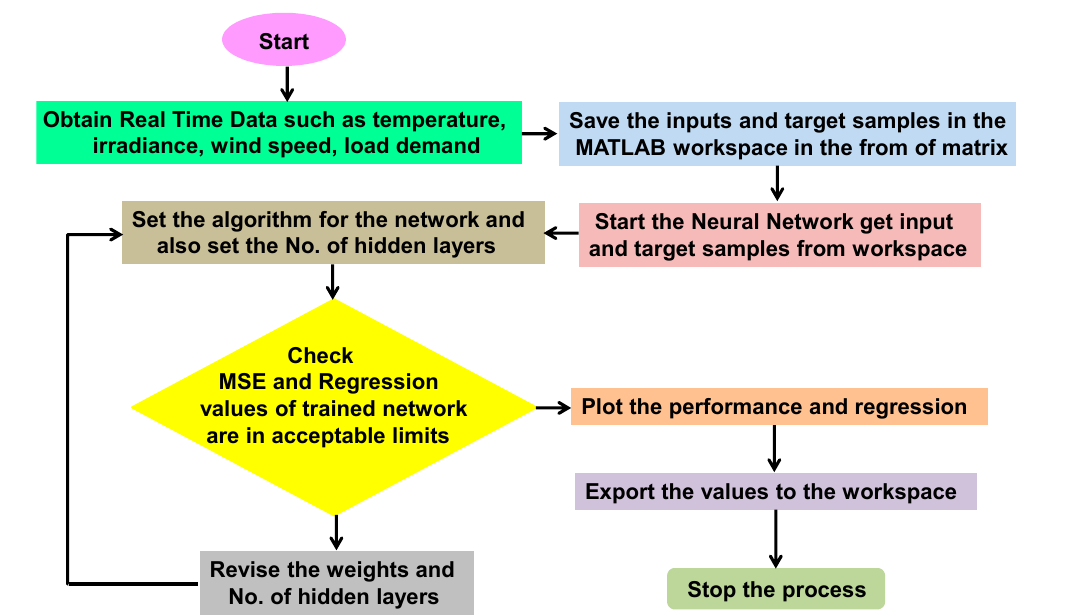
Figure 6. Flowchart for implementing artificial neural networks.